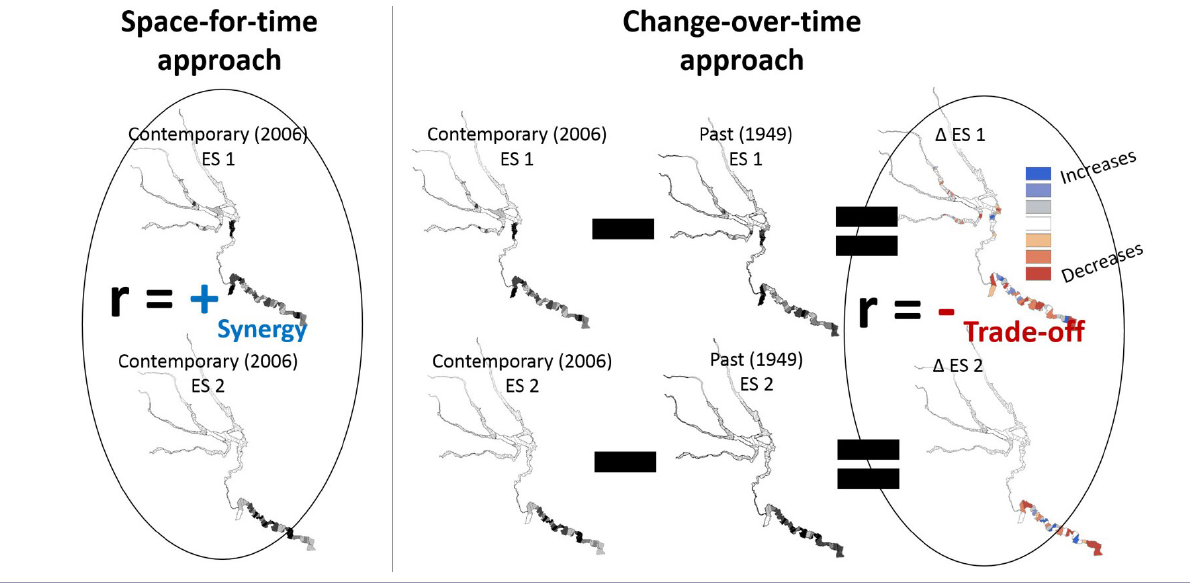
Fig. 4 . Approach for comparing spatial correlations of two different ecosystem services (ES) at one year with change-over-time approaches (∆ES). We correlate the spatial distributions of ecosystem services at the reach level and compare these results to those correlating map differences in ecosystem services from 1949 to 2006 (∆ES).